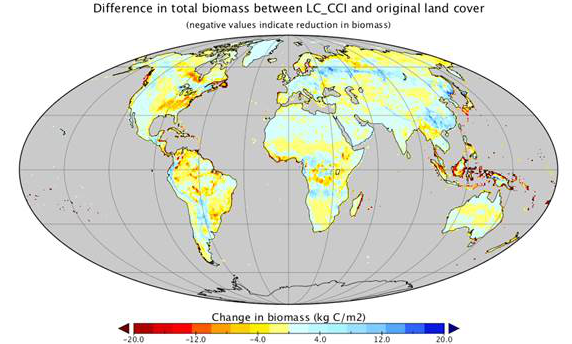
Figure 10. Difference in total biomass between CCI-LC and original LC products (negative values indicate reduction in